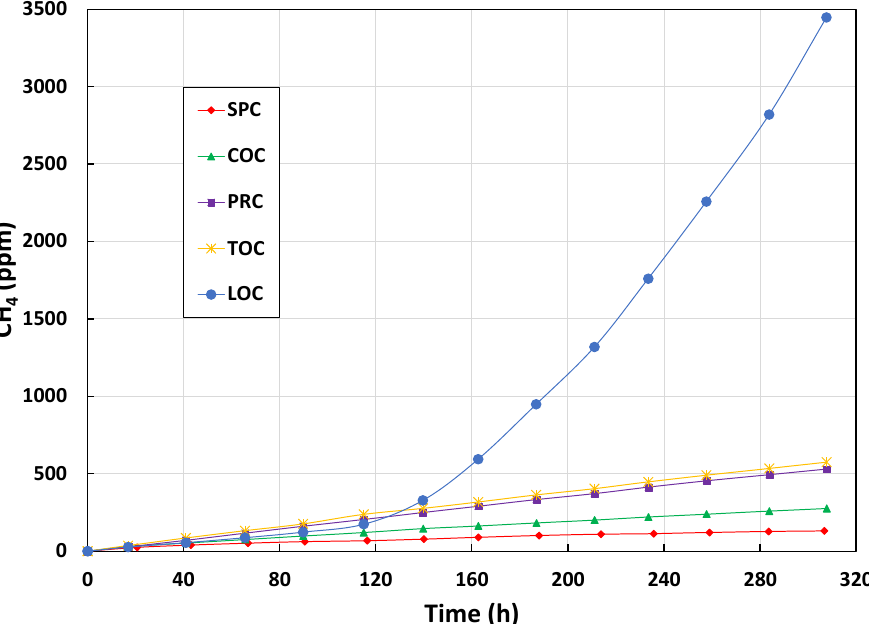
Figure 3. Cumulative mean concentrations of methane (CH4) in the containers over the thirteen-day test period for each of the five materials. Pellets made from: SPC—100% synthetic pure cellulose, COC—cellulose plus 10% coconut oil, PRC—cellulose plus 10% pine rosin, LOC—cellulose plus 10% linseed oil, TOC—cellulose plus 10% tall oil.